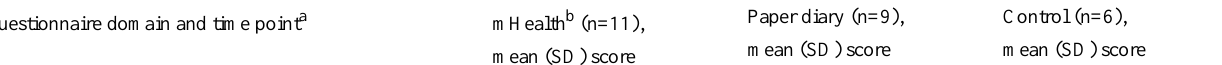
Table 1. Descriptive statistics on PROMIS-57 and PROMIS Global